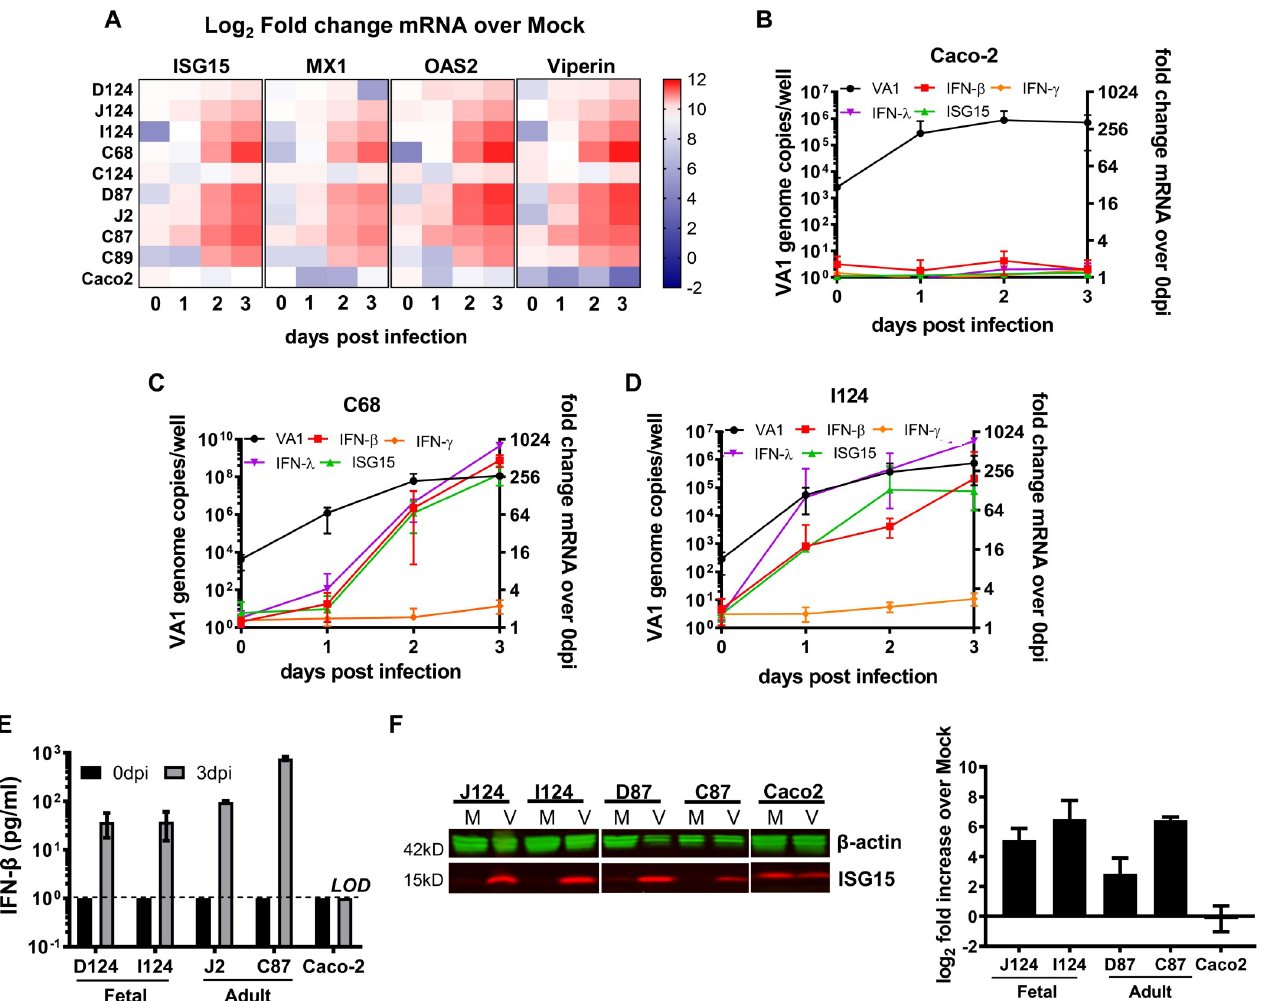
Fig 5. HIEs mount interferon responses to VA1 infection. A) Heat map of ISG15, MX1, OAS2 and Viperin (RSAD2) mRNA fold increase over mock during VA1 infection of HIE derived from different human intestinal segments and Caco-2 cells. B-D) Timecourse of IFN- β , IFN- γ , IFN- λ and ISG15 mRNA expression in VA1 infected Caco-2 cells ( B ), C68 HIE ( C ), and I124 HIE ( D ). VA1 infected cells were harvested at selected dpi and cellular RNA was extracted for VA1 quantification by RT-qPCR (left y-axis) and for the remaining transcripts quantification as fold increase over 0 dpi by qPCR (right y-axis). GADPH was used as internal control. E) IFN- β is secreted during VA1 infection in HIE but not in Caco-2 cells. D124, I124, D87, J2 and Caco-2 cells were infected with VA1 or mock infected (MOI of 1). Supernatants were collected at 3 dpi and ELISA was used to measure IFN- β . F) Mock and VA1-infected HIE and Caco-2 cells lysates were collected at 3 dpi. ISG15 protein levels were analyzed and quantified by Western blot using the secondary LI-COR fluorescent antibodies. Β eta-actin was used as internal control. Images were acquired with LI-COR Odyssey Imager and quantified with ImageJ software for the densitometry analysis. Representative blots are shown on the left for fetal (J124 and I124) and adult (D87 and C87) VA1 infected HIE. Quantification of the data is shown on the right. N � 3; error = mean ± SD. Abbreviations: D = duodenum, J = jejunum, I = ileum, C = colon, M = mock infection, V = VA1 infection. The numbers indicate patient identifiers. � P < 0.05; ��� P < 0.001; ND = not detected; LOD = limit of